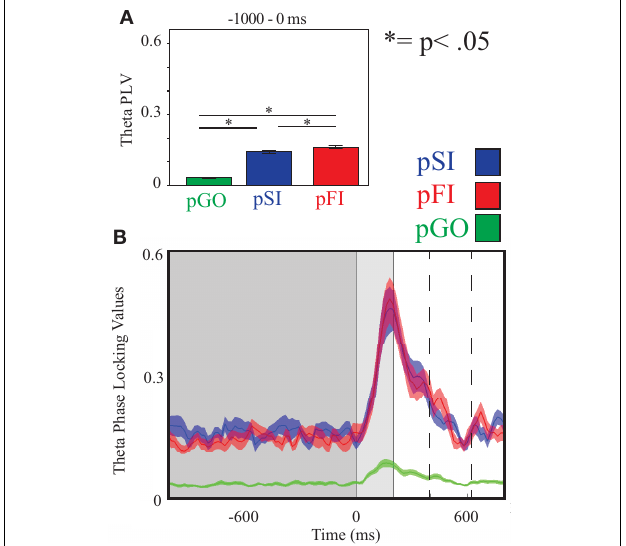
FIGURE 4 | Theta inter-trial coherence (ITC) at electrode FCz. (A) Bar graph displaying mean ITC averaged over the − 1000 to 0ms interval, with 0ms as GO stimulus onset. (B) Line plot illustrating ITC from − 1000 to + 1000ms, with the dark gray highlighting the ITI, the light gray bar after 0ms highlights maximal coherence following stimulus onset, and the dashed lines indicating ITC centered around the “Go” response.